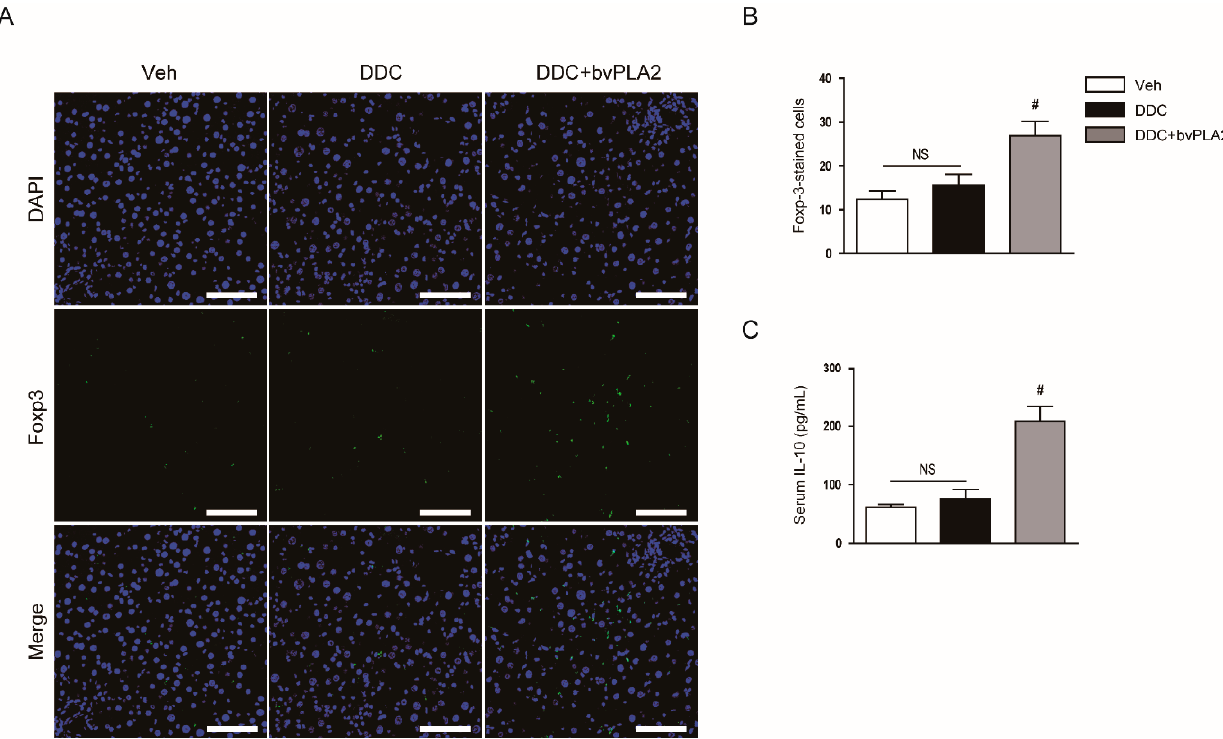
Figure 7. Effect of bvPLA2 on regulatory T-cells in DDC diet-fed mice. ( A ) Immunofluorescent staining of liver tissues for forkhead box protein P3 (Foxp3). Scale bar = 50 μ m. (B ) Number of Foxp3-stained cells. ( C ) Serum interleukin-10 (IL-10) levels. n = 8 per group. # p < 0.05 vs. DDC. NS, not significant.